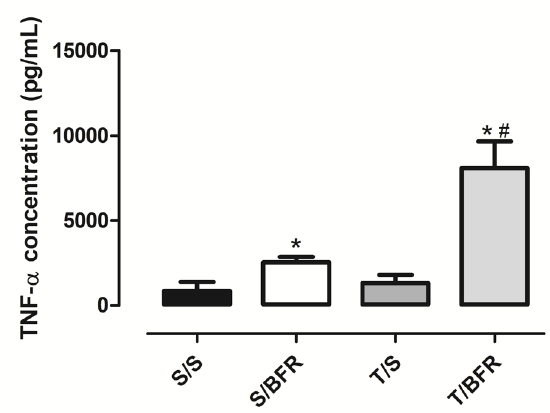
Figure 5. Measurement of the concentration of TNF-α in serum. Sedentary groups (S/S), sedentary with blood flow restriction (S/BFR), strength trained (T/S) and strength trained with blood flow restriction (T/ BFR). Data are expressed as mean ± SEM. Experimental n is 12 to 16. *different to S/S, p < 0.001; # different to T/S, p =